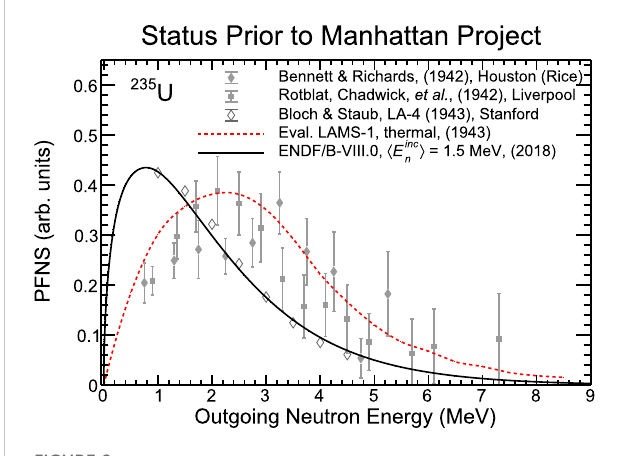
The PFNS for neutrons on 235 U, showing the state of understanding when the Manhattan Project was beginning, taken from LAMS-1 [5]. The ENDF/B-VIII.0 evaluation is a modern thermal assessment by the IAEA [10,11,17]. An image of the original data from Los Alamos report LA- 4 is shown in the Appendix Supplementary Figure